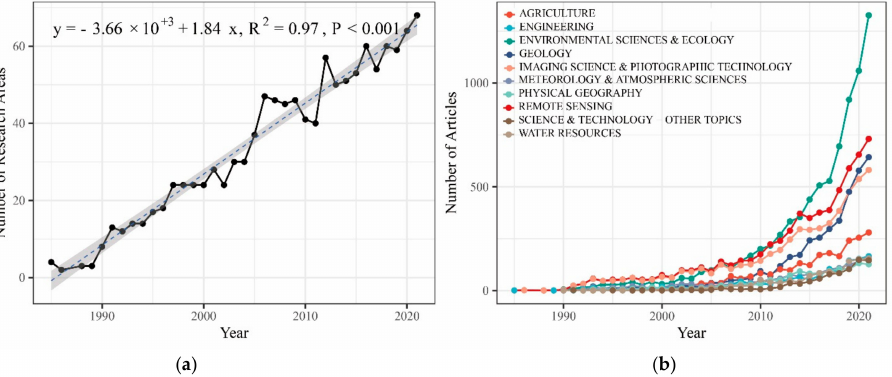
Figure 3. ( a ) Number of WOS research areas covered in NDVI-related literature. ( b ) Temporal evolution of the top ten most productive WOS research areas in NDVI-related